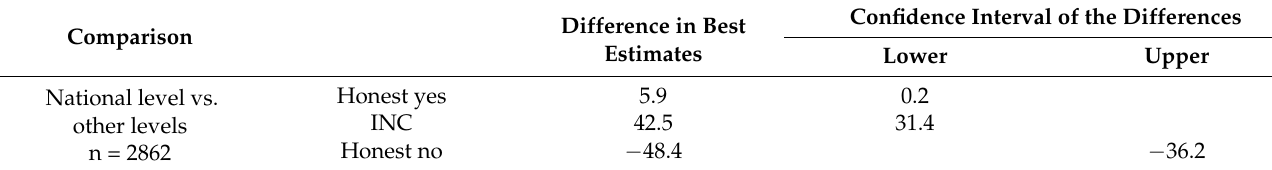
Figure 3. Prevalence of doping by level of competition participation. Table 1. Test for significance, hypothesis 1: The prevalence of doping is at its highest at the second highest level of competition participation.